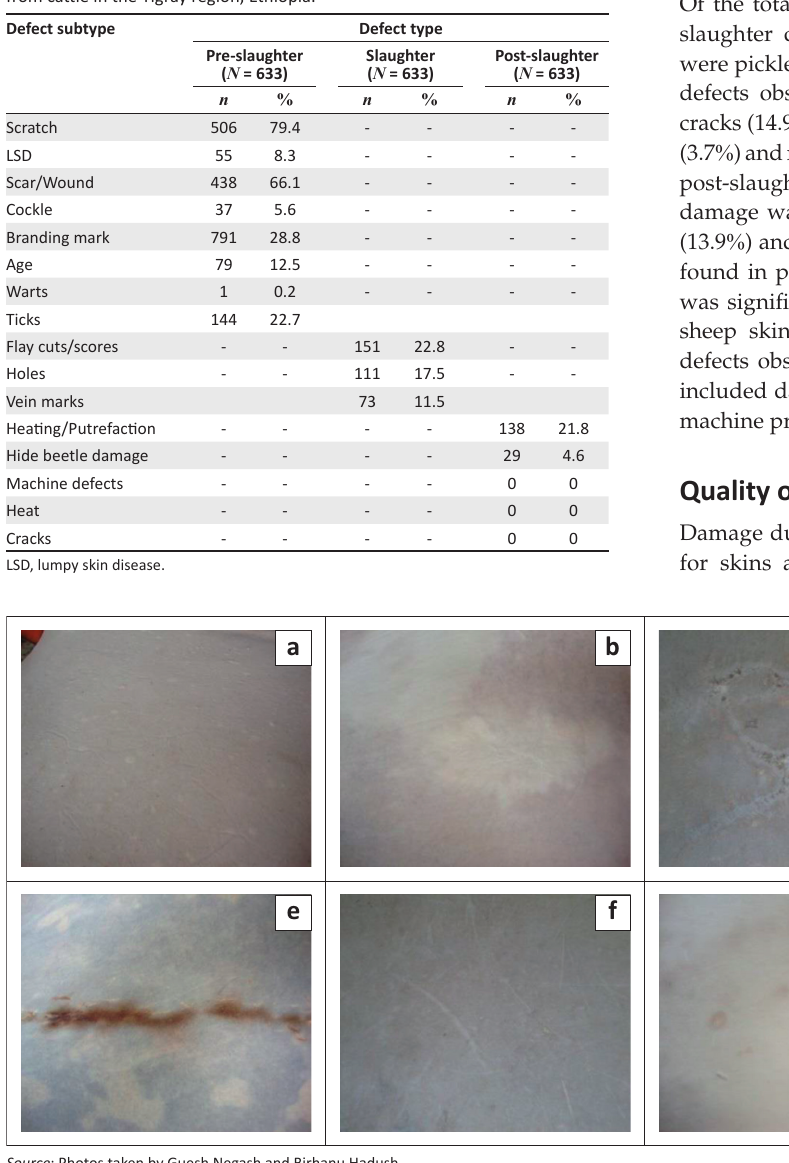
FIGURE 1: Major pre-slaughter defects seen in hides and skins: (a) pox lesions; (b) cockle ( ekek ); (c) branding marks; (d) tick damage; (e) aged skins; (f) grain scratch; (g) wart lesions.